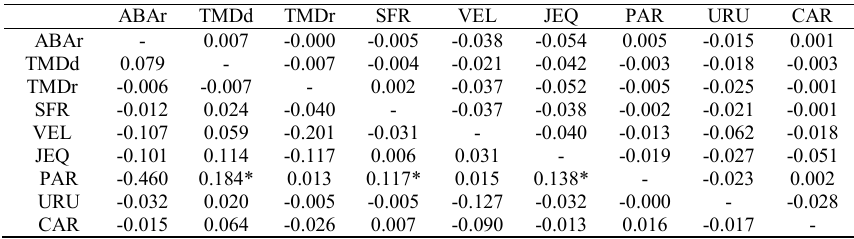
Table 3. Pairwise F (above diagonal) and pairwise R (bellow diagonal) values for Prochilodus argenteus . * P < 0.05, after ST ST Bonferroni correction.ABAr = rio Abaeté at rainy season; CAR = rio Carinhanha lagoons; JEQ = rio Jequitaí lagoons; PAR = rio Paracatu lagoons; SFR = rio São Francisco lagoons; URU = rio Urucuia lagoons; VEL = rio das Velhas lagoons; TMDd = Três Marias Dam at dry season; TMDr = Três Marias Dam at rainy